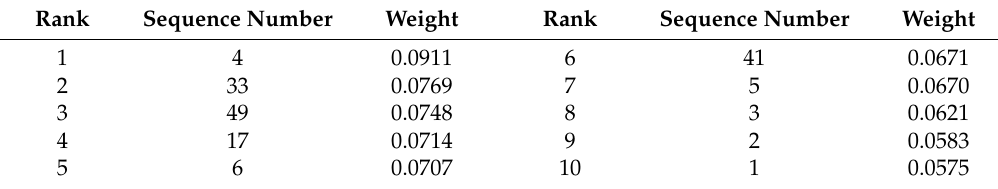
Figure 6. Weight line chart of 54 features in 2015. Table 4. Weights of the first 10 features in 1990.